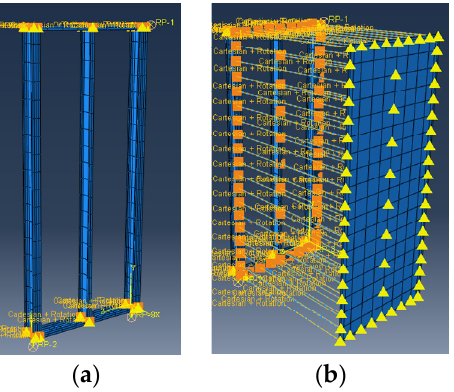
Figure 16. The finite element models of the CFS shear wall with SPR: ( a ) Cartesian connector elements in CFS frame, ( b ) Cartesian connector elements between the CFS frame and steel sheathing.